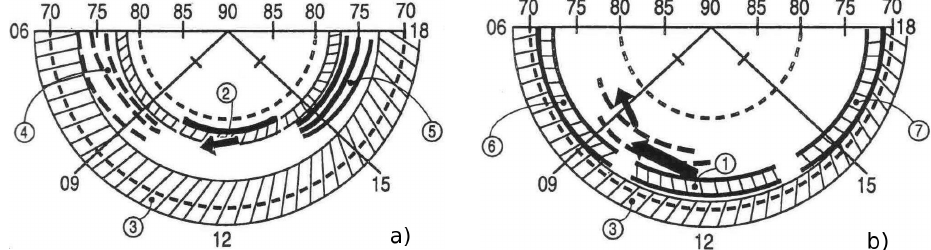
Figure 19. Schematic distribution of dayside auroras for different regimes of B IMF z and B IMF y components: (a) B z > 0 and B y > 0, (b) B z < 0 and B y > 0. Seven different types of aurorae are marked by labels. Auroral motions Type 1 and Type 2 are indicated by arrows. The direction to the sun is downward in the figure (Sandholt et al.,